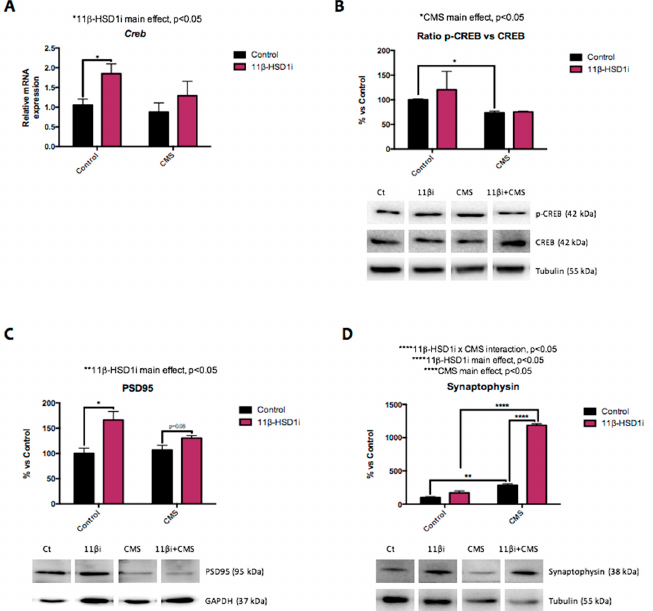
Figure 7. Representative results from neuroplasticity modulators. Relative gene expression of Creb ( A ). Representative Western blot for the ratio of p-CREB protein levels and quantification ( B ), PSD95 protein levels and quantification ( C ), and synaptophysin protein levels and quantification ( D ). Gene expression levels were determined by real-time PCR. Western blot values in bar graphs are adjusted to 100% for protein levels of SAMP8 Control (Control). Values are mean ± standard error of the mean (SEM) ( n = 6 for each group). 11 β -HSD1 and CMS main effects as well as interactions were determined. * p < 0.05; ** p < 0.01; **** p <